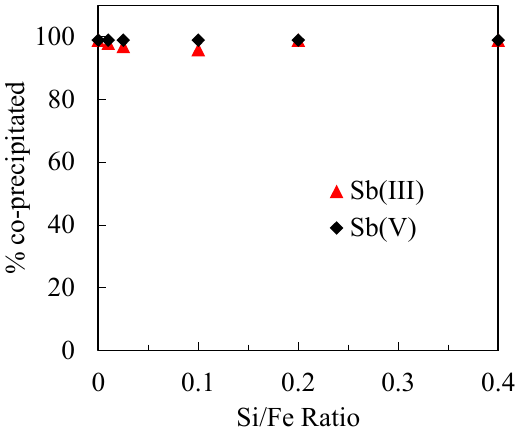
Figure 8. Co-precipitation of Sb(III/V) with different Si/Fe ratios of ferrihydrite at pH 7. The initial Sb(III/V) concentrations were 100 µM for all samples.